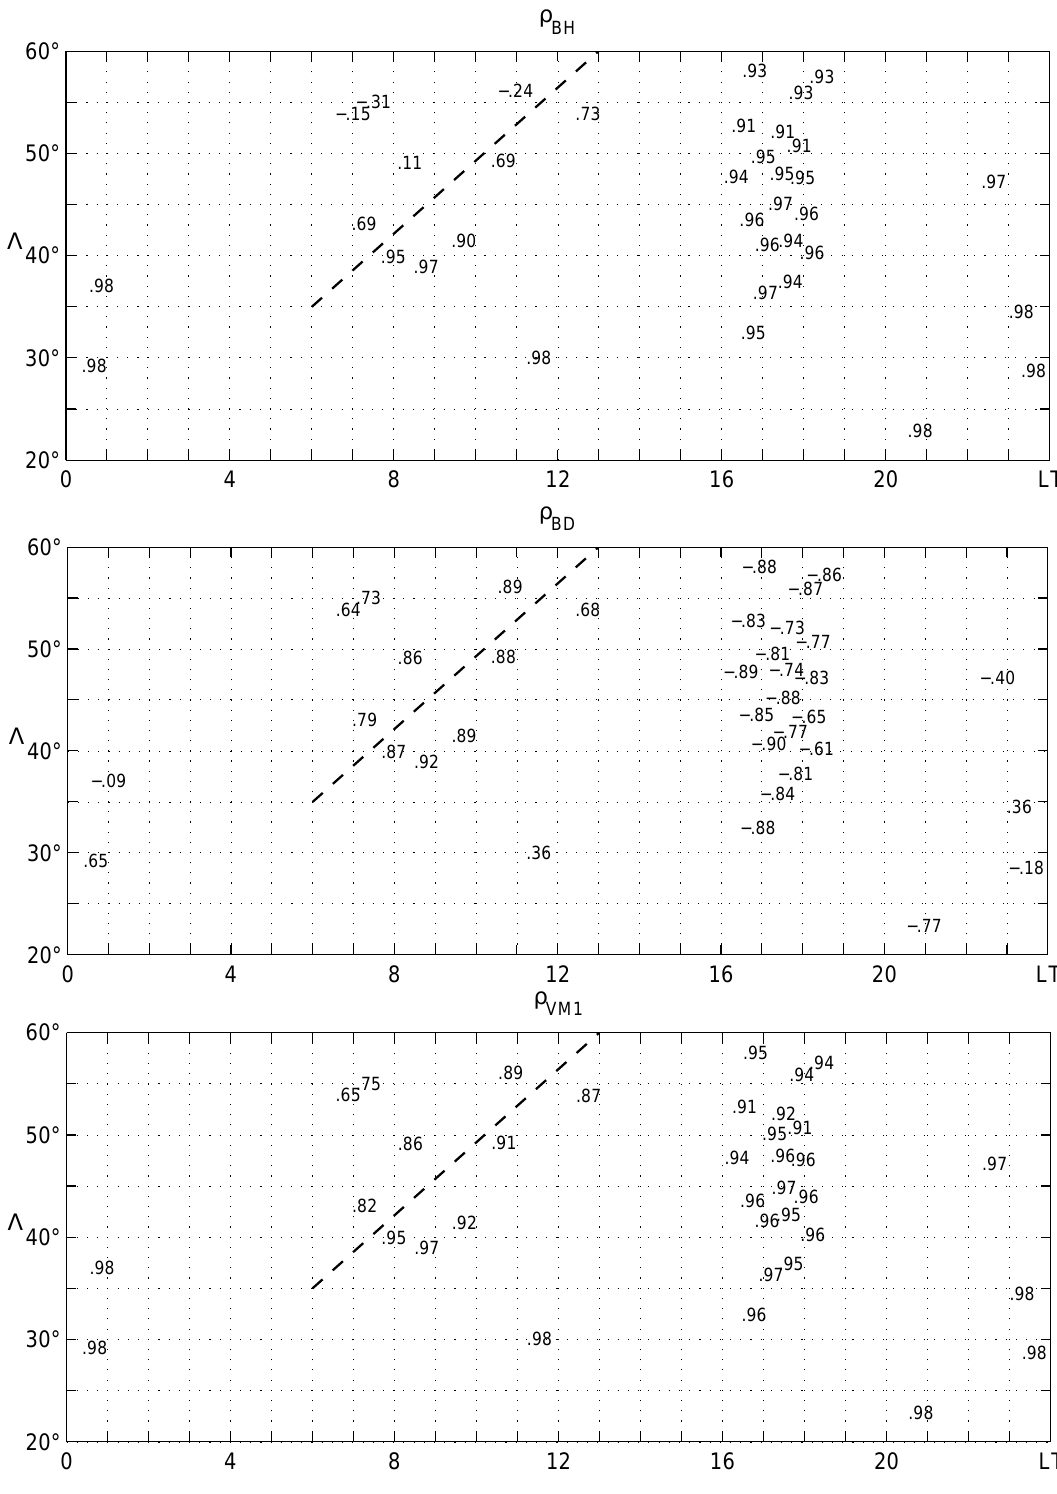
Fig. 5. The correlation coefficient between the magnetospheric field B and the geomagnetic field elements for the time interval 15:30– 16:20 UT. Top panel: correlation with the H component ( ρ BH ) ; central panel: correlation with the D component ( ρ BD ) ; bottom panel: correlation with the field projection along the maximum correlation axis ( ρ VM 1 )